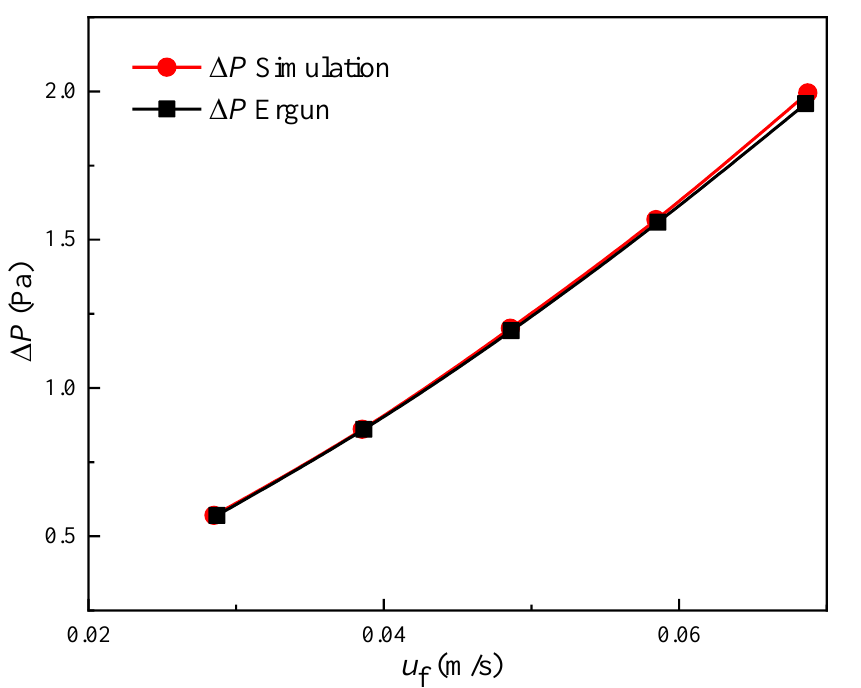
Figure 8. Comparison of pressure drop with gas velocity from simulations and the Ergun equation.